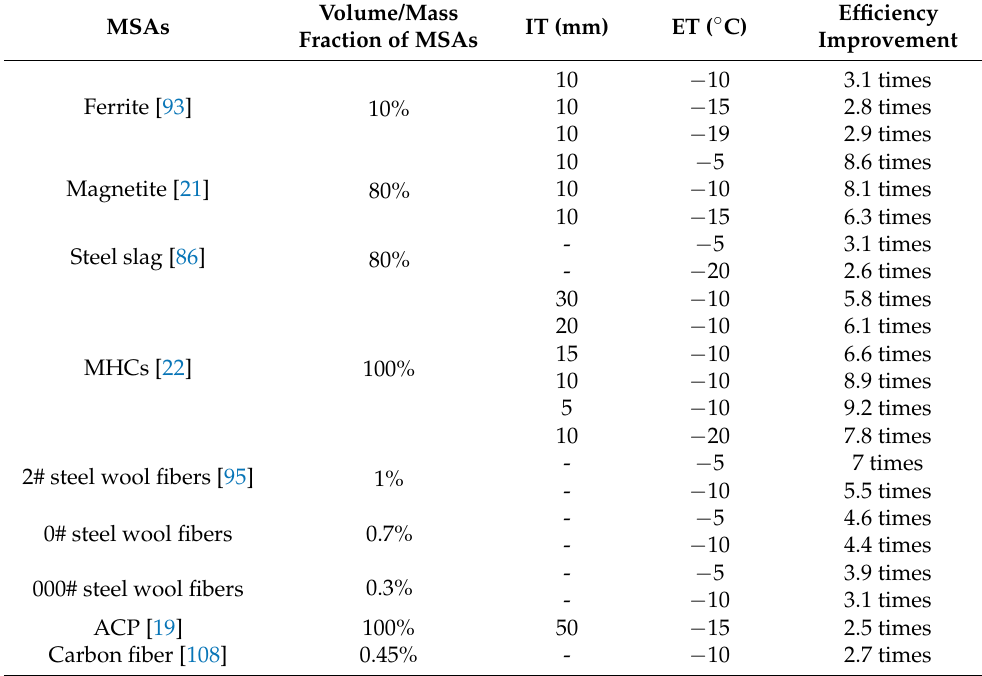
Table 3. De-icing efficiency of the asphalt mixtures containing different MSAs using 2.45 GHz